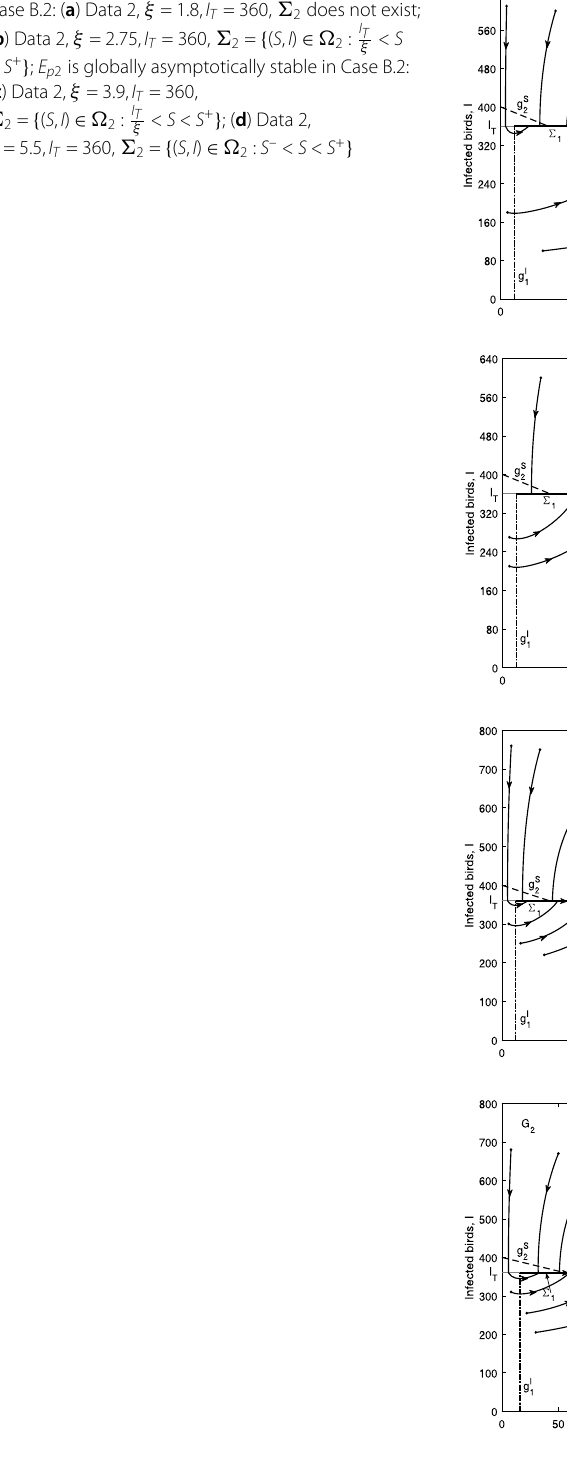
Figure 7 E p 1 is globally asymptotically stable in Case B.2: ( a ) Data 2, ξ = 1.8, I T = 360, (cid:5) 2 does not exist; ( b ) Data 2, ξ = 2.75, I T = 360, (cid:5) 2 = { ( S , I ) ∈ (cid:4) 2 : IT ξ <